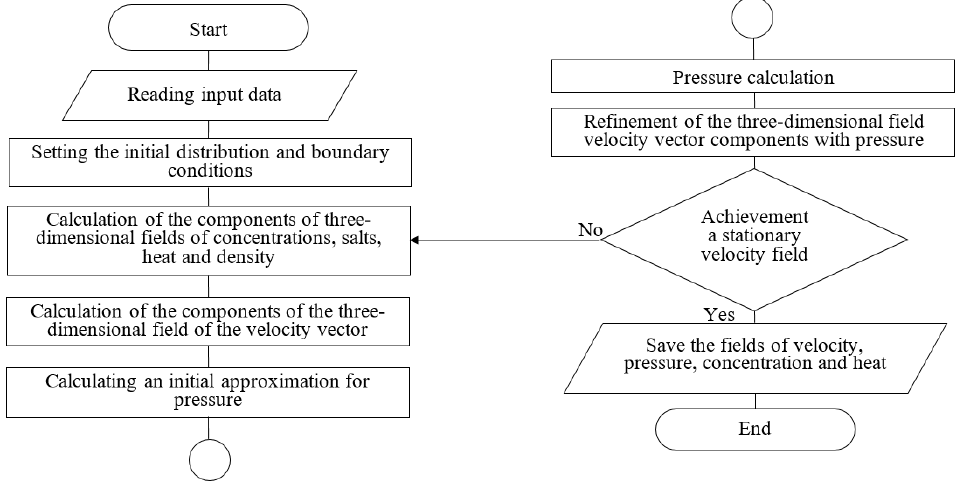
Figure 3. Program module block diagram.